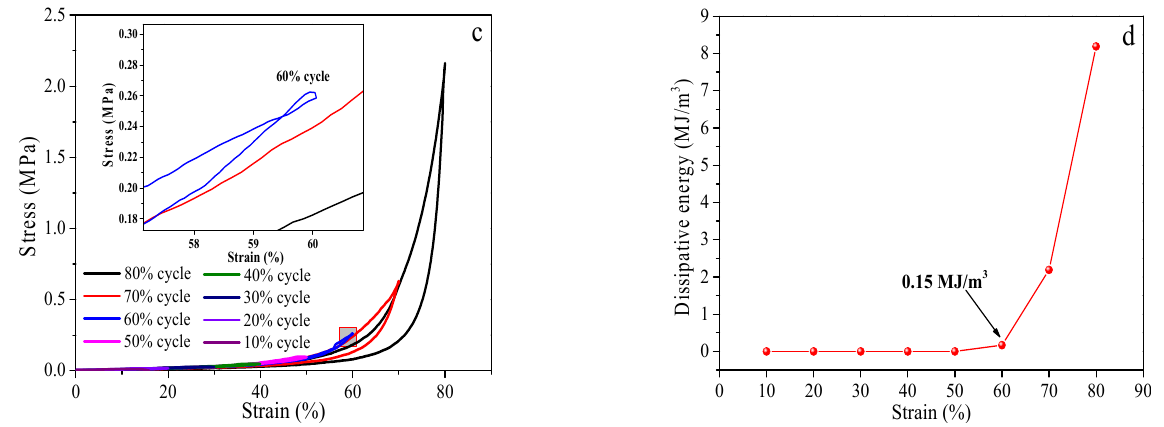
Figure 6. Cyclic compression and dissipation energy of hydrogel under different strains (cyclic compression ( a ) and dissipative energy ( b ) of PAM hydrogel; cyclic compression ( c ) and dissipative energy ( d ) of p–DN hydrogel).